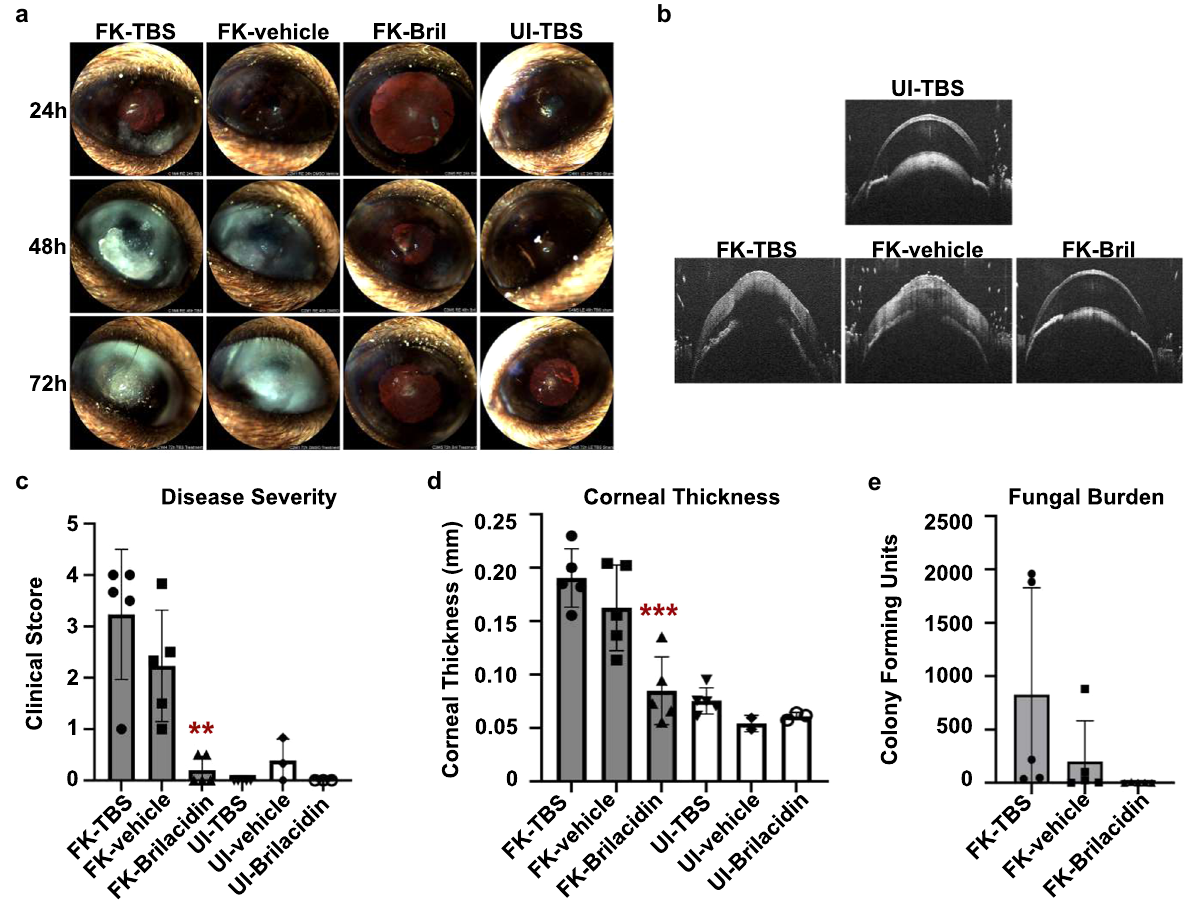
Fig.7|TopicalBRItreatmentblocksfungalgrowthanddiseasedevelopmentin a murine model of fungal keratitis. a Representative slit-lamp images of unin- fected (UI) or A. fumigatus infected (FK, fungal keratitis) murine corneas. Animals were treated multiple times daily with drops containing Tris-buffered saline (TBS), vehicle (TBS+12.5% DMSO), or brilacidin (2.5mM Bril + vehicle) as indicated. b Representative optical coherence tomography (OCT) scans of the indicated groups at72hp.i. c Disease scoring of allcorneasat72hp.i.based onthe slit-lamp images. d Thickness measurements of all corneas at 72h p.i. derived from OCT